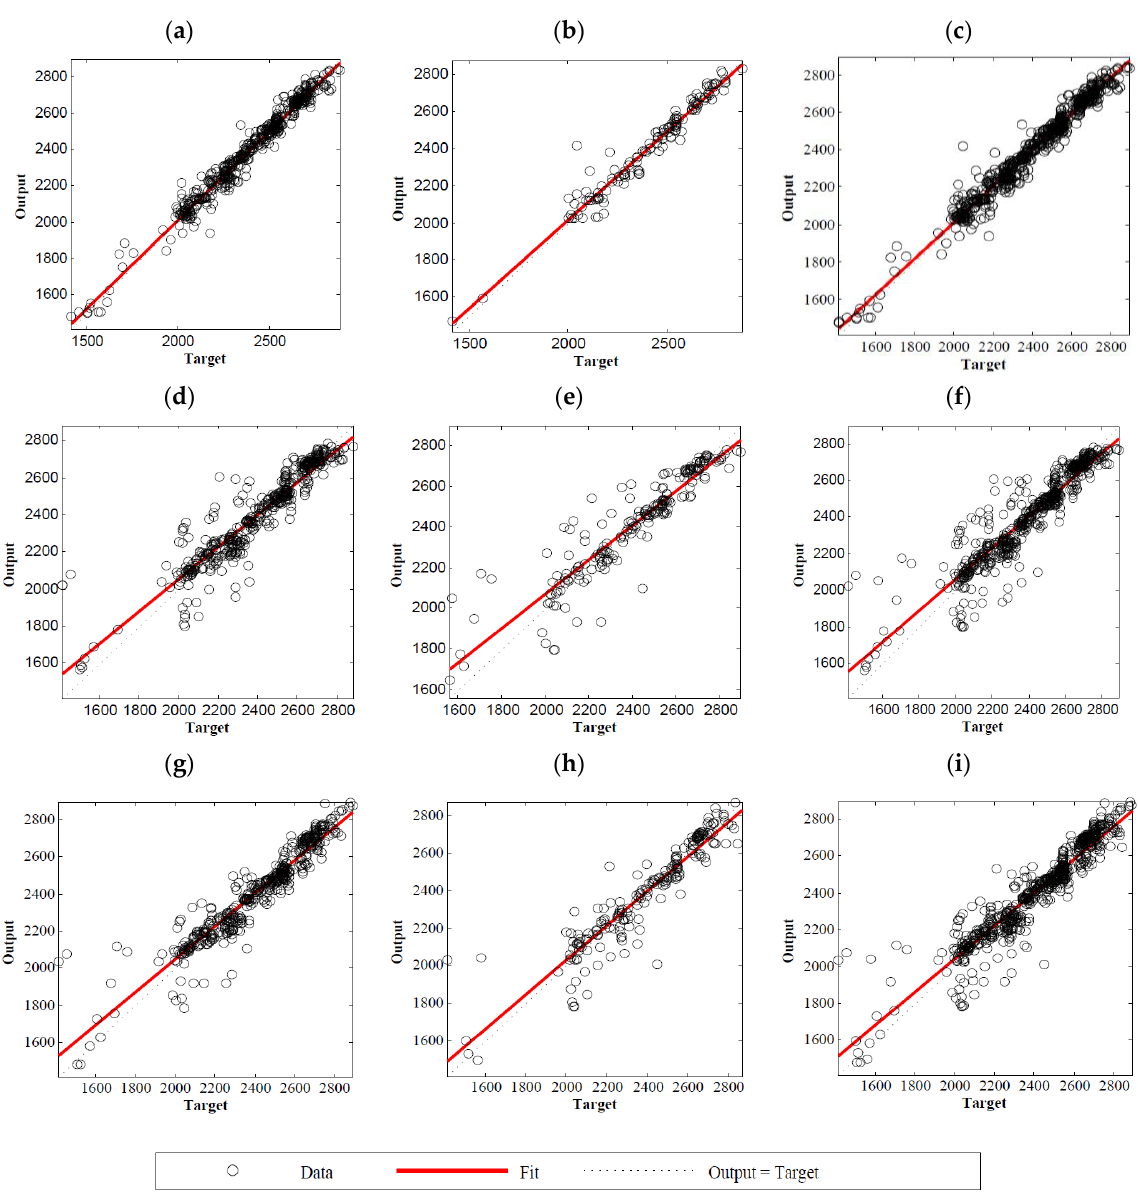
Figure 5. Representation of the correlation between the estimated and actual shear wave velocity. So that, ( a – c ) represent the proposed method results, subfigures ( d – f ) illustrate the results of MLP model, and the results of the original GMDH model are shown in ( g – i ). (from left to right, columns represent the results for train, test, and all data, respectively).